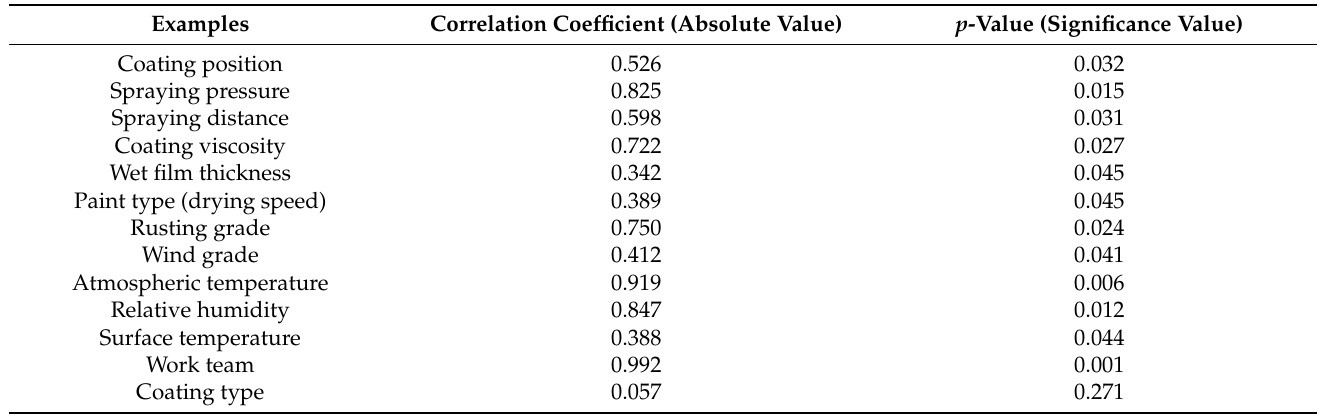
Table 3. Correlation coefficients and significant values.